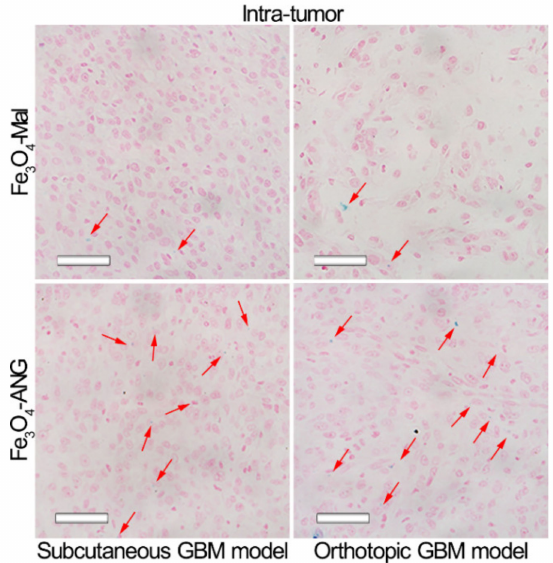
Figure 6. Prussian blue staining of the subcutaneous glioblastoma model and the orthotopic glioblas- toma model after injection of Fe 3 O 4 -Mal or Fe 3 O 4 -ANG NPs. The Scale bar is 50 µ